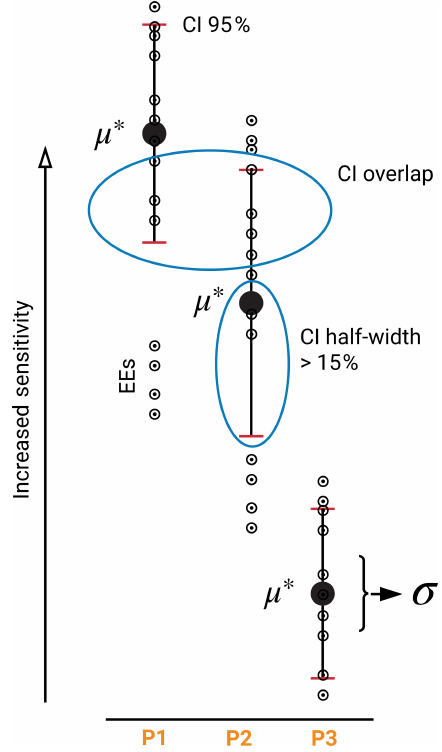
Figure A1. Illustration of derivation of presented metrics. Blue cir- cles show the two criteria used to judge the quality of the results. µ ∗ is calculated based on the EEs (circles); however, the CI is cal- culated based on bootstrap resamples of the simulation